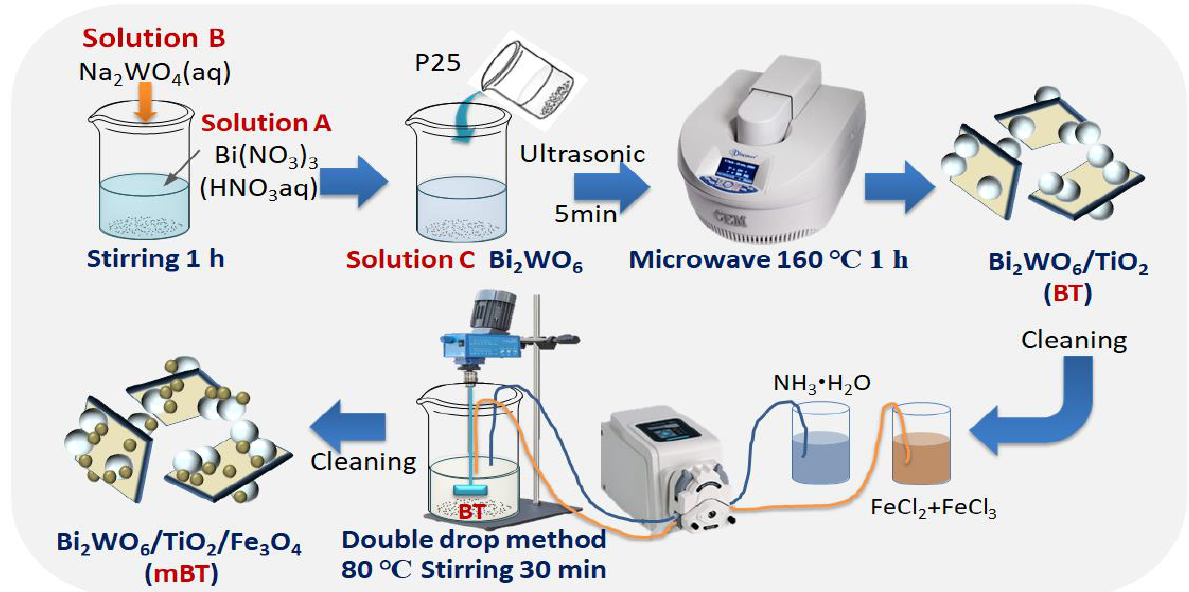
Figure 1. The schematic diagram of the synthesis of mBT and the ammonia iron double drop method.